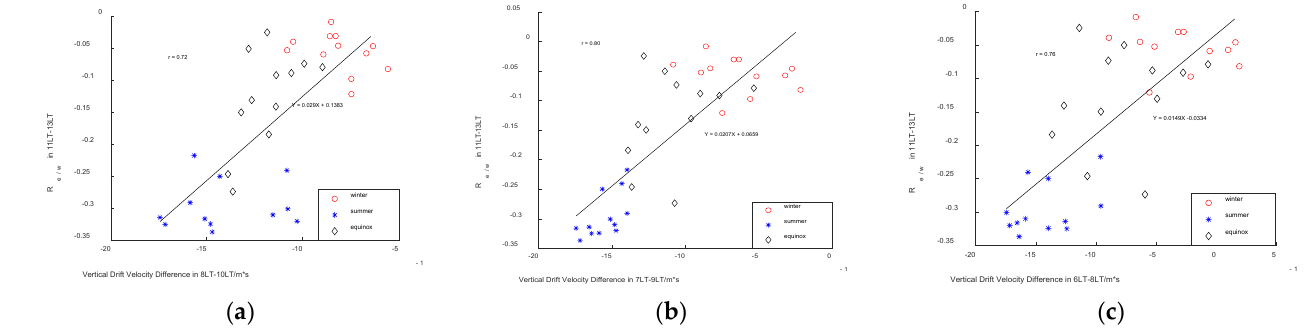
Figure 7. ( a ) Correlation between the TEC longitudinal differences index R e/w in 11LT–13LT and the vertical drift velocity difference in 8LT–10LT in high solar activity years. ( b ) Correlation between the TEC longitudinal difference index R e/w in 11LT–13LT and the vertical drift velocity difference in 7LT–9LT in high solar activity years. ( c ) Correlation between the TEC longitudinal difference index R e/w in 11LT–13LT and the vertical drift velocity difference in 6LT–8LT in high solar activity years. To further explore the contribution of meridional wind and zonal wind to the iono- spheric longitude difference caused by the neutral wind velocity difference in East Asian daytime, using Equation (2), we calculated the ratio of the vertical drift velocity difference caused by meridional wind ∆ ( − sin I cos I ∗ U sin D ) to the total drift velocity difference V ∆ and the ratio of the vertical drift velocity difference ∆ ( − sin I cos I ∗ V cos D ) caused by zonal wind to the total drift velocity difference ∆ V z in 7LT–9LT. As shown in Figure 8, the ratio of zonal wind vertical velocity difference to total drift velocity difference is greater than 1 in most cases, while the ratio of meridional wind vertical velocity to total drift velocity difference is less than 0 in most cases. During some periods, the zonal wind contri- bution is less than 1, but the ratio is still more than 0.8. These results indicate that the zonal wind-geomagnetic declination mechanism is the dominating cause for the daytime TEC longitudinal difference in the East Asian midlatitude, and meridional wind makes a small contribution and can even reduce the vertical velocity difference. In addi- tion, we calculated the correlation coefficient between the vertical drift velocity difference caused by 7LT–9LT zonal wind and the TEC longitude index R e/w during 11LT–13LT. It is found that the correlation coefficient is 0.846, which is higher than that between the overall neutral wind velocity difference and the ionospheric longitude index R e/w , confirming that the ionospheric longitude difference around noon is mainly caused by the zonal wind- geomagnetic declination mechanism in the East Asian midlatitude. ( a ) ( b ) Figure 8. ( a ) The ratio of vertical drift velocity difference ( sin cos sin ) I I U D ∆ − ∗ caused by zonal wind to the total drift velocity difference z V ∆ ( b ) The ratio of vertical drift velocity difference ( sin cos cos ) I I V D ∆ − ∗ caused by horizontal wind to the total drift velocity difference z V ∆ .